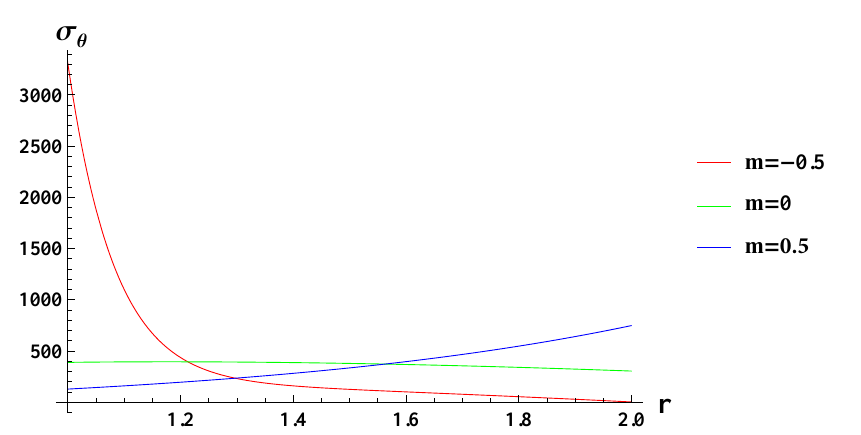
Figure 13. Tangential stress (in MPa) along the radius r (in cm) of the cylinder, under the effect of rotation ( ω 2 = 50 rad/s), internal pressure p i = 50 MPa and linear volume reinforcement. Radial strain rate as seen in Figure 14 is compressive at internal radial points and tensile at outer radial points of the cylinder for decreasing reinforcement profile. Under increasing reinforcement profile, strain rate in radial direction is higher at internal radial points but decreases at the outer radius. It increases from the inner radius of the cylinder to its outer radius under composite material gradation m = 0 with compressiveness at inner radial points.